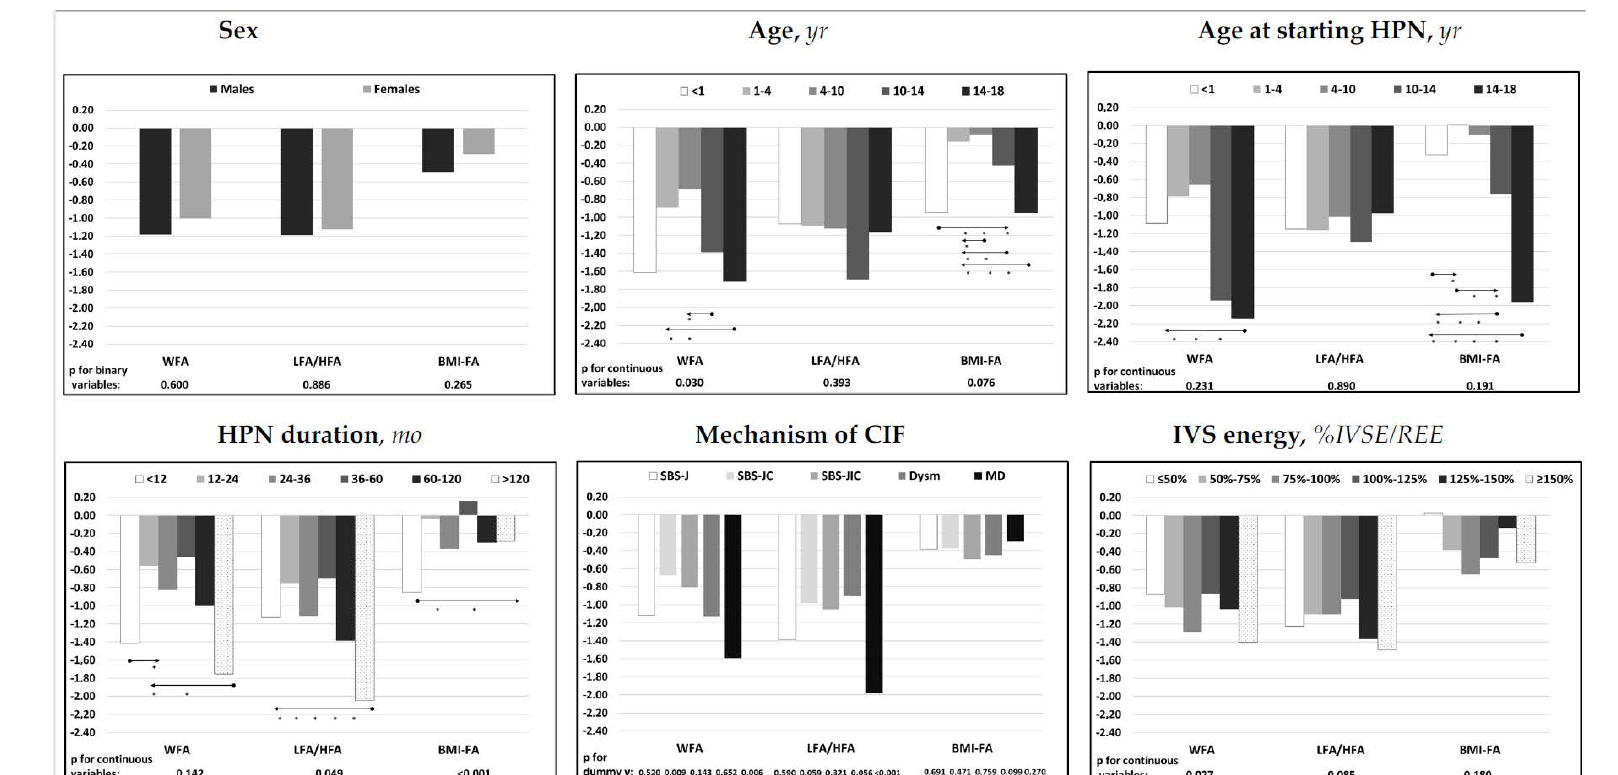
Figure 3. Associations of median z-scores for age of the nutritional status parameters with patients’ characteristics and with intravenous supplementation energy. Statistic: Spearman’s test was used for the continuous variables; Mann–Whitney’s test for the binary variable sex; the categorical variable “mechanism of CIF” was dichotomized, and each dummy variable was analyzed individually. The relative effects between the categories of the ordinal variables were compared using the nonparametric multiple comparisons for relative effects test with Tukey’s test for the contrasts. * p < 0.05 between categories; direction of the comparison. Abbreviations: WFA, body weight for age; LFA/HFA, body length for age (patients aged 0–2 years) or height for age (patients aged > 2 years); BMI-FA, body mass index for age; IVS energy (%IVSE/REE) , ratio of daily intravenous supplementation total energy over estimated resting energy expenditure; HPN, home parenteral nutrition; CIF, chronic intestinal failure; SBS-J, SBS with end jejunostomy or ileostomy (also included enterocutaneous fistulas, n. 7); SBS-JC, jejuno-colic anastomosis; SBS-JIC, jejunoileal anastomosis with an intact colon and ileocecal valve; Dysm, dysmotility (also included patients with mechanical obstruction, n. 8); MD, mucosal